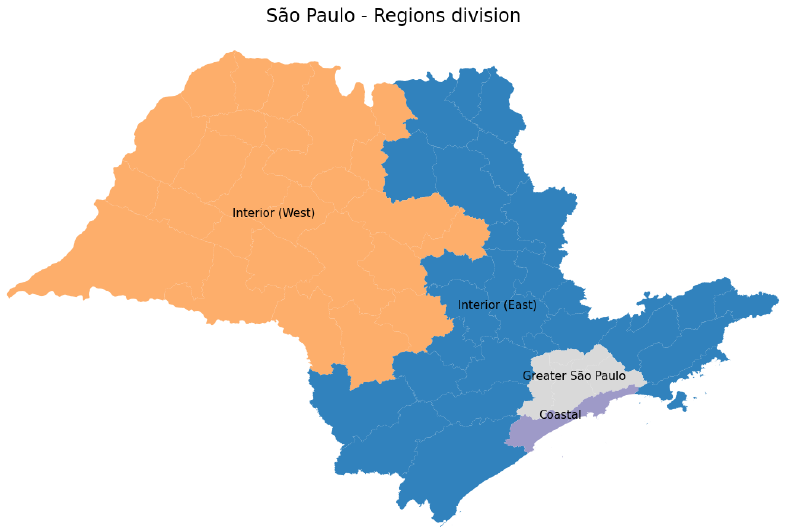
Figure 9. São Paulo state